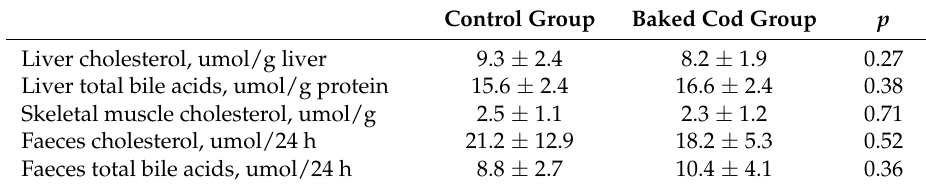
Table 5. Cholesterol and total bile acids in liver and faces, and cholesterol in skeletal muscle. Control Group